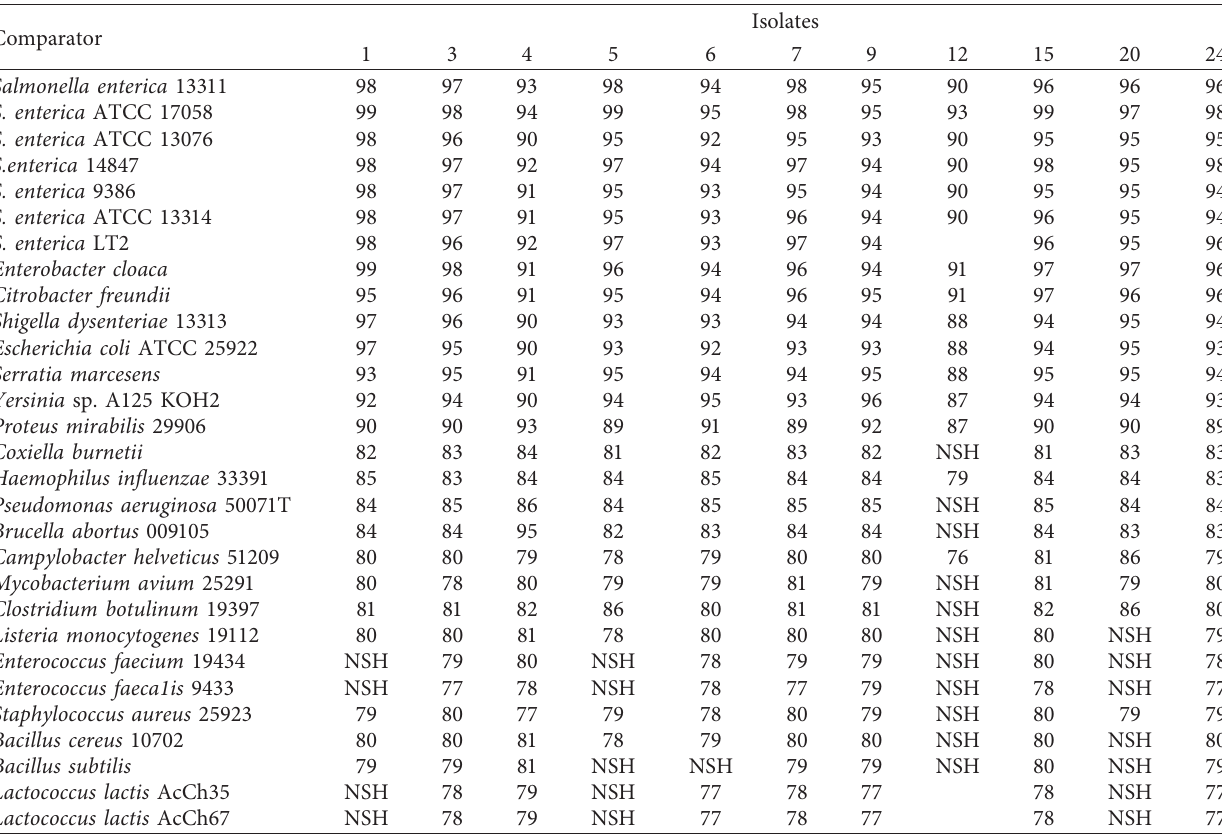
Table 5: Sequence similarities in percent of the study isolates to the 16S rRNA gene sequences obtained from the database.